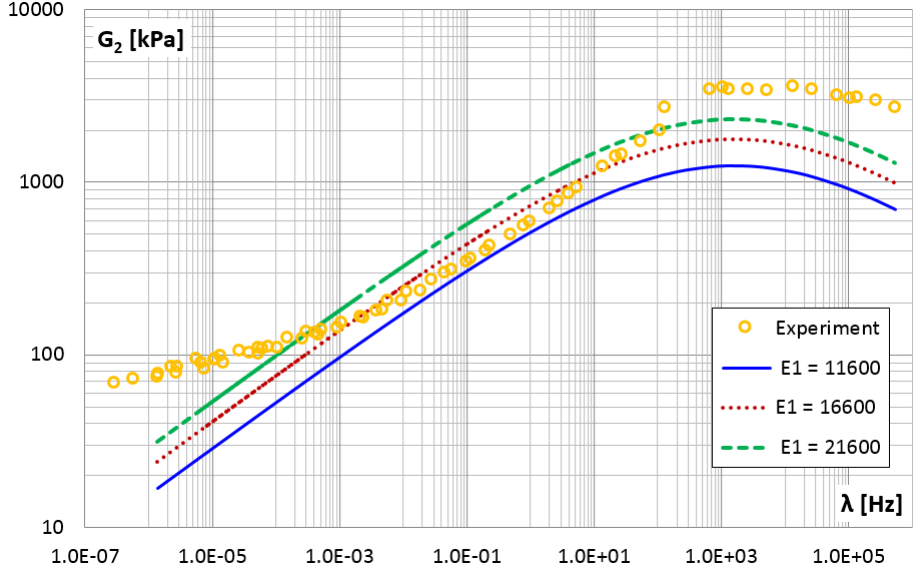
Figure 23. The shear loss modulus G 2 vs. frequency for different values of parameter E 1